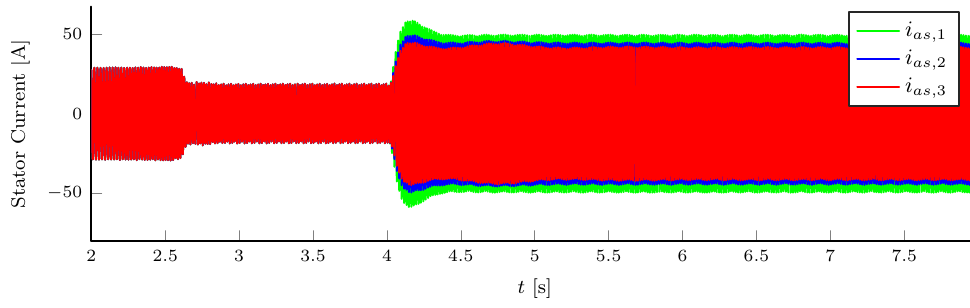
Figure 14. Phase a stator currents; voltage-source control. In Figure 14, a phase stator currents are shown for all motors. After 4 s, the motor − currents display different peak currents; these differences correspond to the application of unequal load torques and differences in motor input